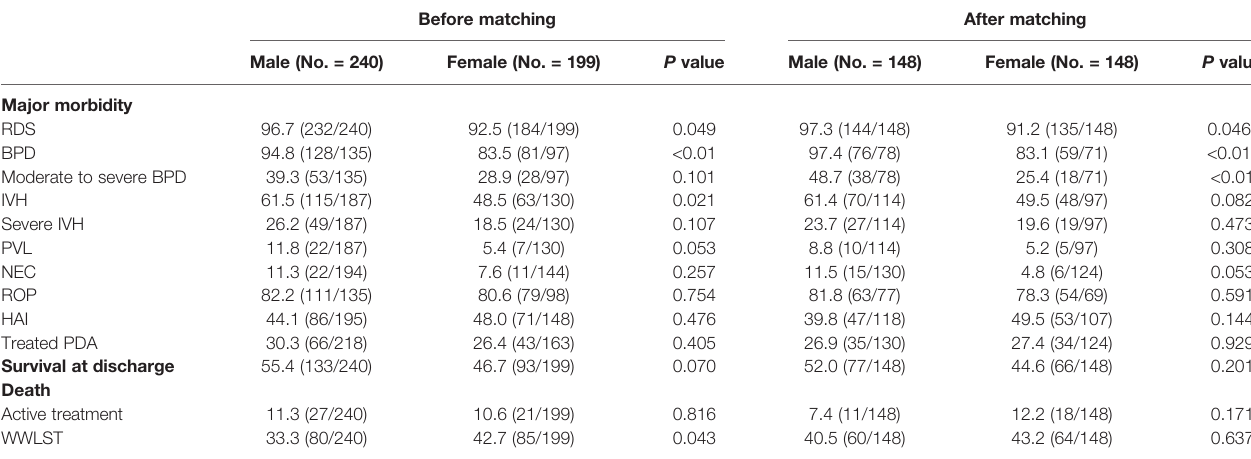
TABLE 2 | The clinical outcomes of the EPIs (%[diagnosed No./assessed No.]).